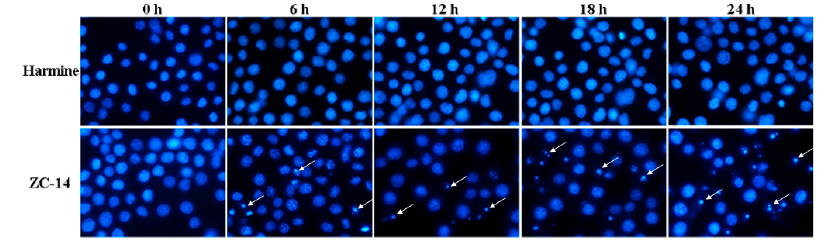
Figure 4. Sf9 cells treated with 7.5 μ g/mL harmine and ZC-14 were stained with Hoechst 33258 and the nuclear morphology was observed under a fluorescence microscopy (20×). The nuclear condensation was indicated by the arrows.